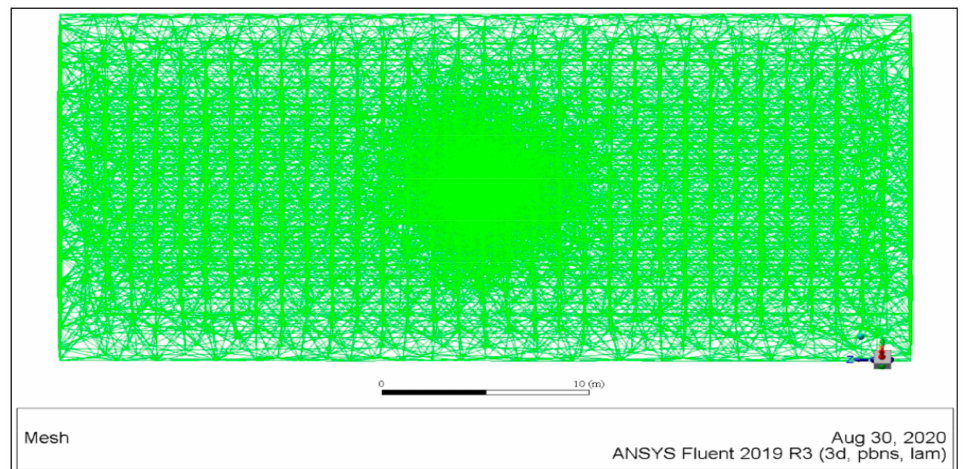
Figure 6. The physical domain considered for the simulation after